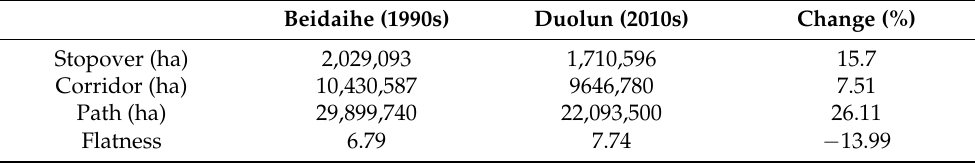
Table 3. Summary the migratory paths of white-naped cranes in the early 1990s and early 2010s. Beidaihe (1990s) Duolun (2010s) Change (%) Stopover (ha) 2,029,093 1,710,596 15.7 Corridor (ha) 10,430,587 9646,780 7.51 Path (ha) 29,899,740 22,093,500 26.11 Flatness 6.79 7.74 −